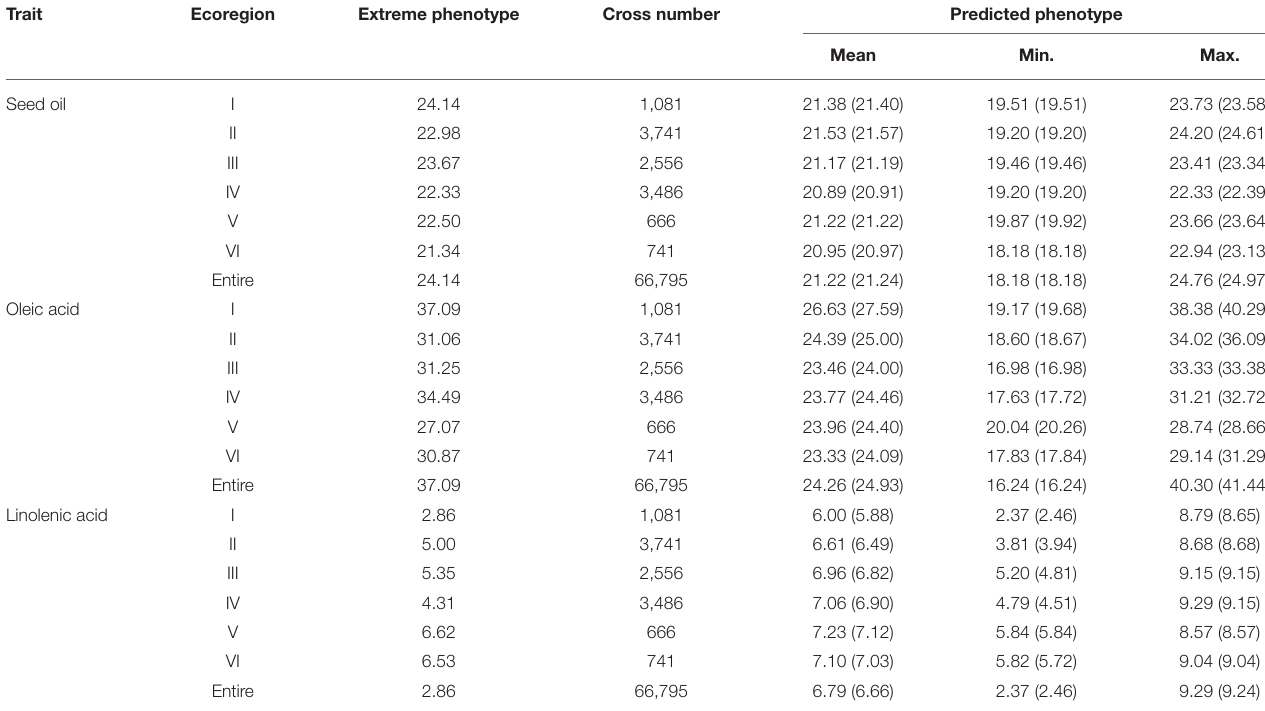
TABLE 7 | The predicted seed oil content, oleic acid, and linolenic acid content for all possible single crosses. Trait Ecoregion Extreme phenotype Cross number Predicted phenotype